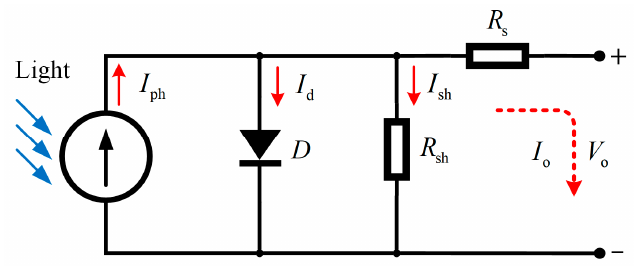
Figure 16. Structure of single diode model.